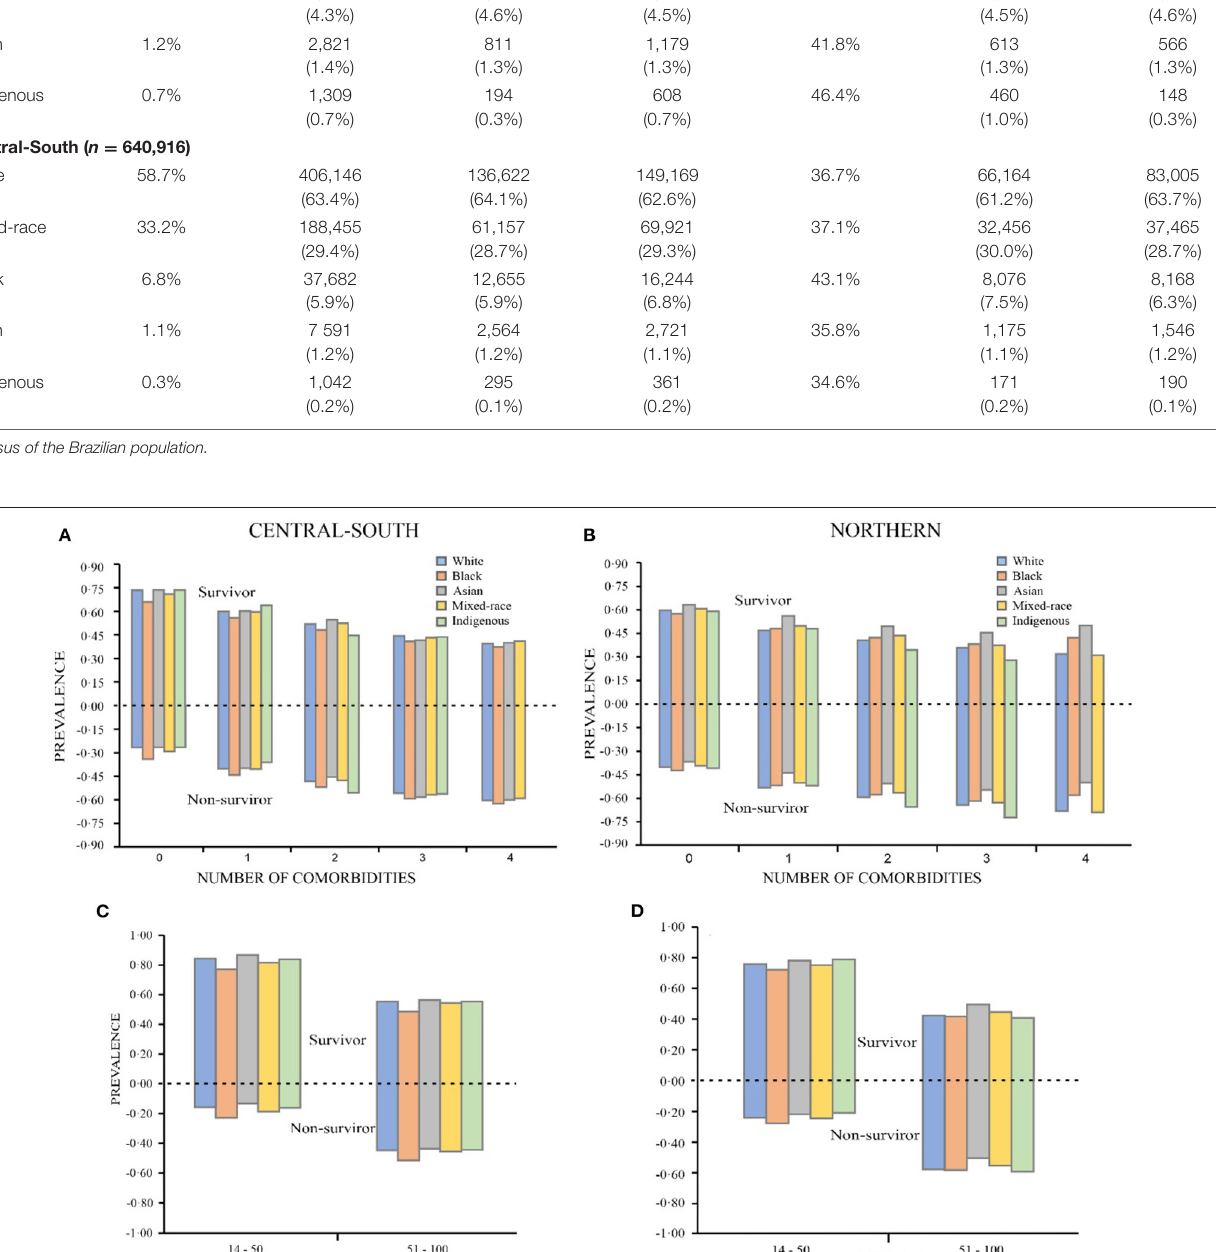
Frontiers in Public Health |